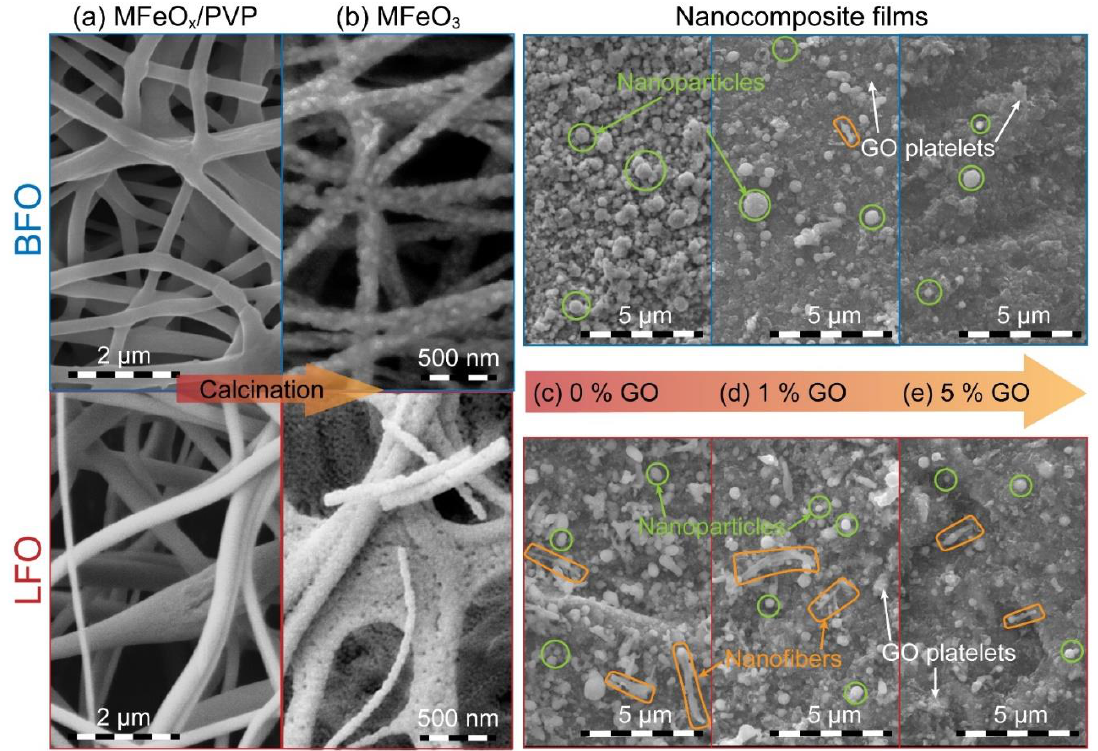
Figure 2. SEM micrographs of ( a ) the as-spun MFeO x / PVP, ( b ) the calcined MFO nanofibers and the nanocomposite films containing 3% ferrite nanofibers and GO concentrations of ( c ) 0%, ( d ) 1% and ( e ) 5%.